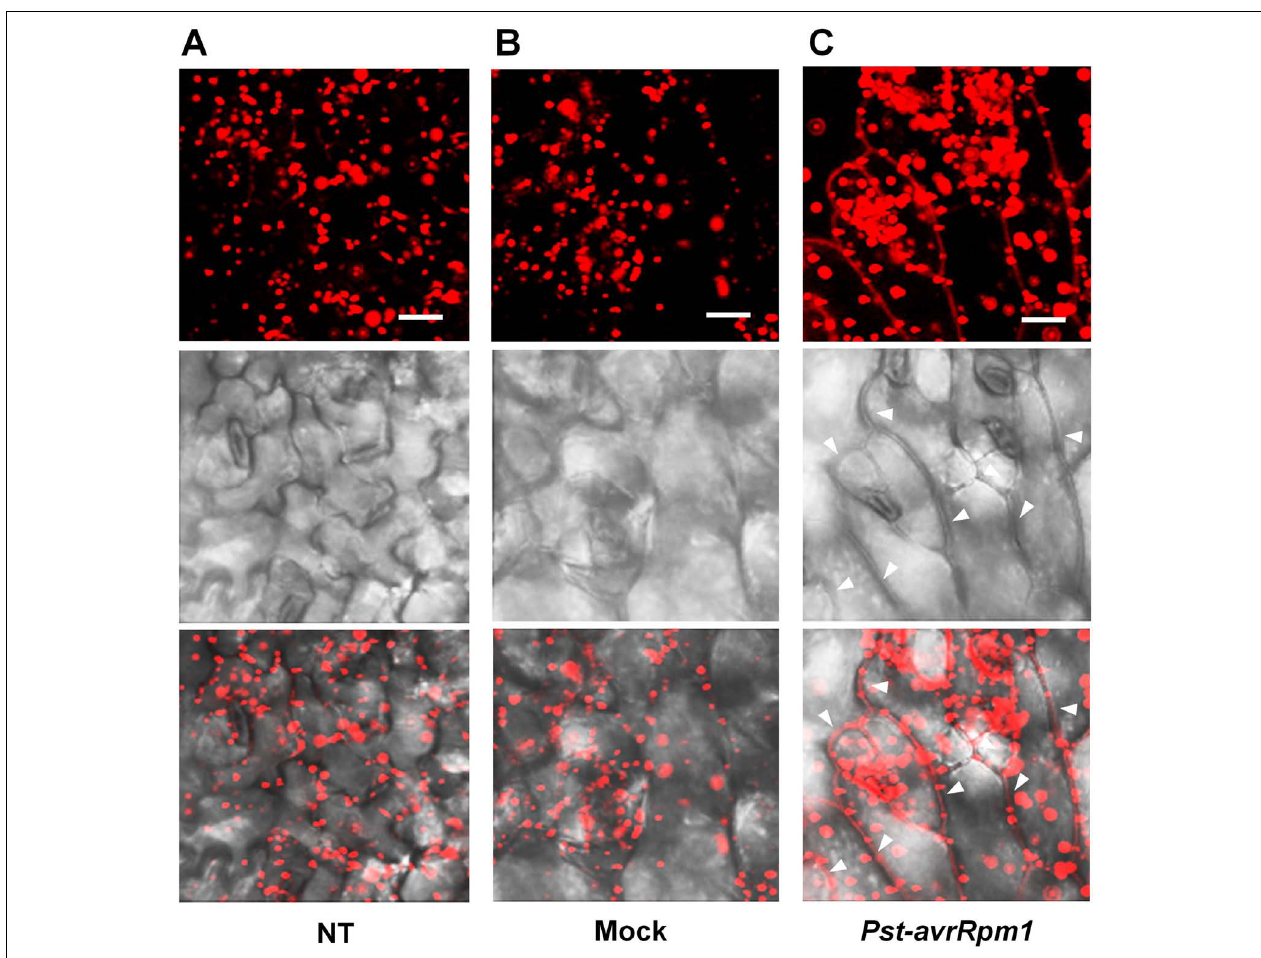
Pst-avrRpm1 (C) compared to the no-treatment control (A) and 0.015% Silwet/10 mM MgCl 2 -treated mock (B) in pre-mature young leaves where PLA 2 α is normally localized primarily in Golgi bodies. Fluorescent (top), bright field (middle), and merged images (bottom) are presented. Bars = 20 μ